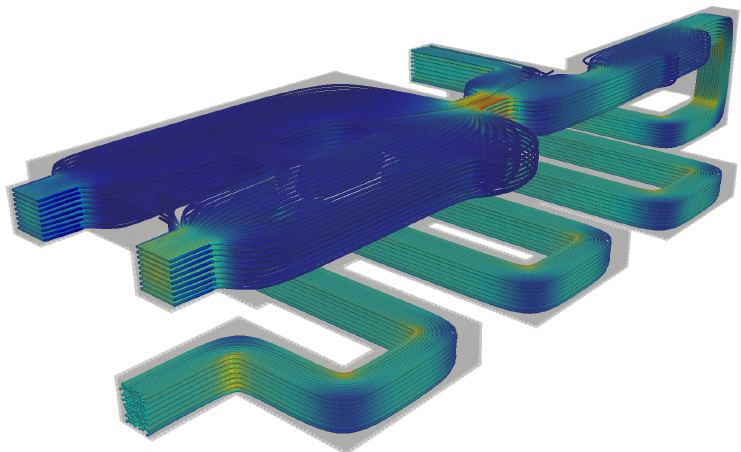
Figure 10. Streamlines for the complex 3D array of channels. The color scale varies from smallest (blue) to largest (red) velocity magnitude.